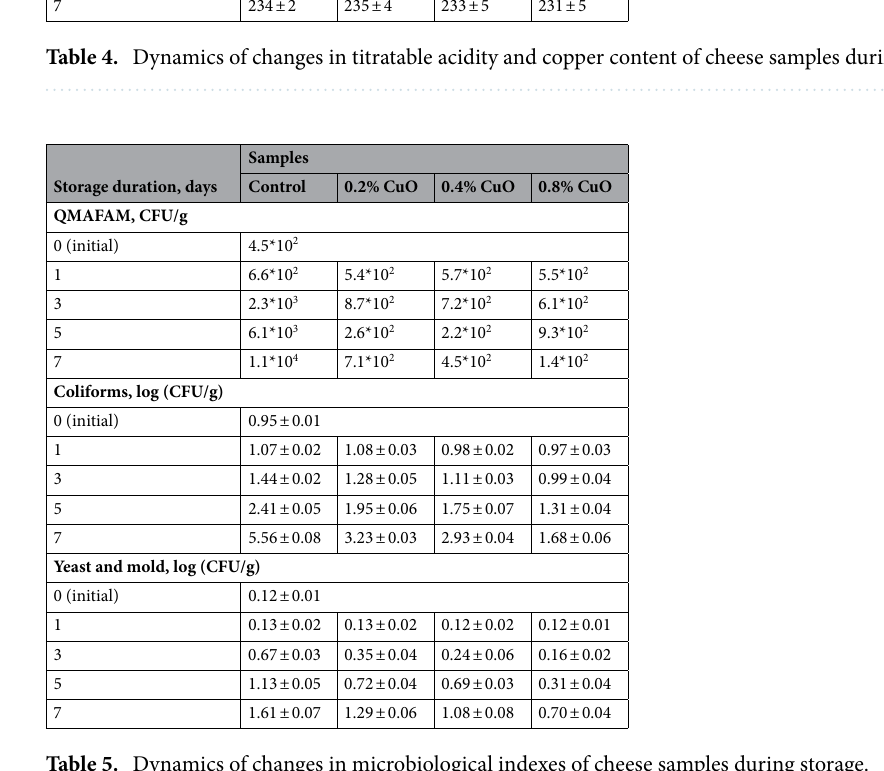
Table 5. Dynamics of changes in microbiological indexes of cheese samples during